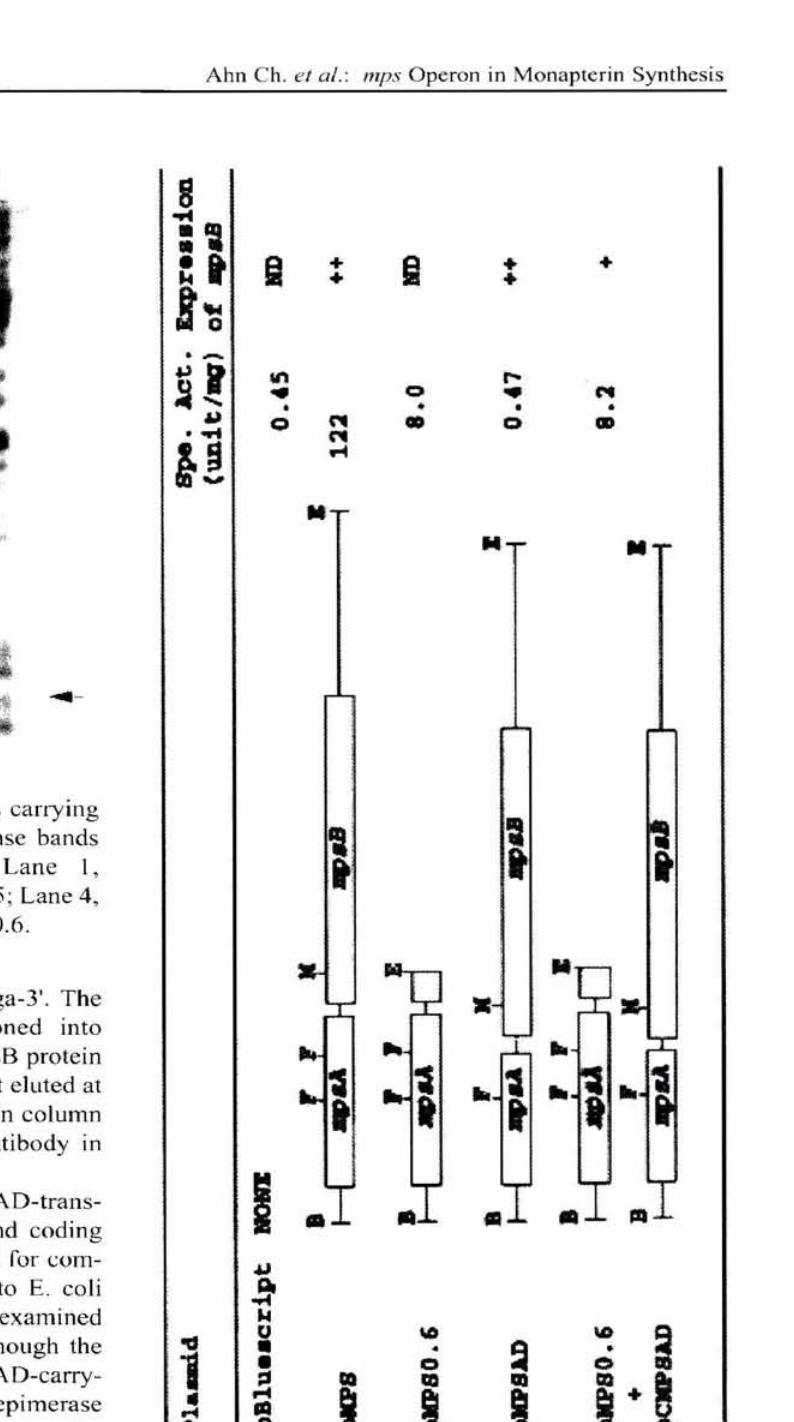
Figure 4. Complementation test for the activation of mpsA by mpsB. Expression of mpsB was monitored by wcstcm blotting using antiscrum against MpsB. (+) denotes expression level of MpsB protein. ND, not detected. E, EcoRl; B, BamH\\ F, EcoRV; M, Mlu\.